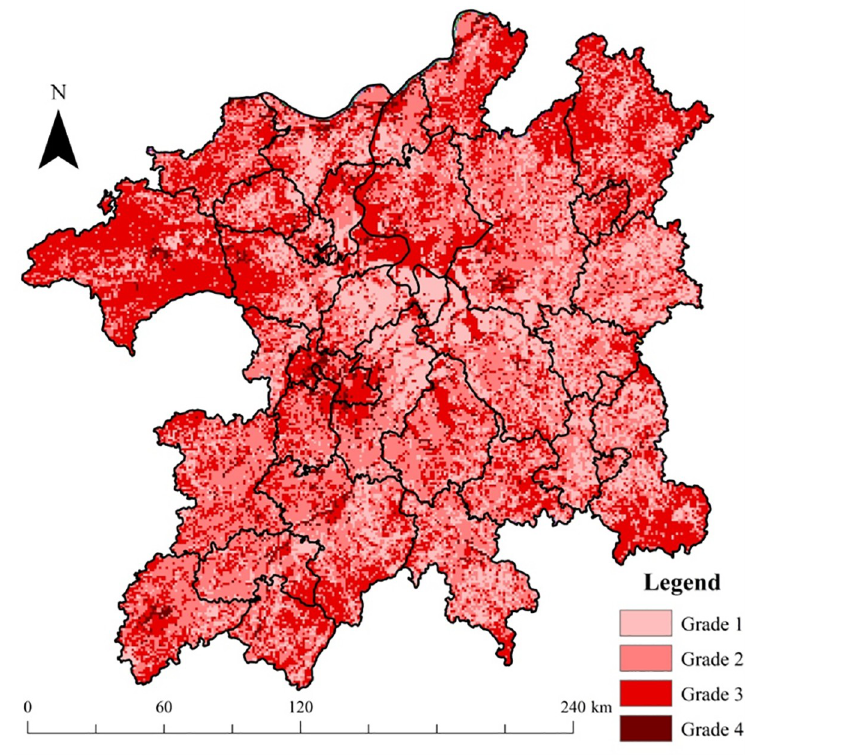
Fig 9. Distribution of final risk grades in the